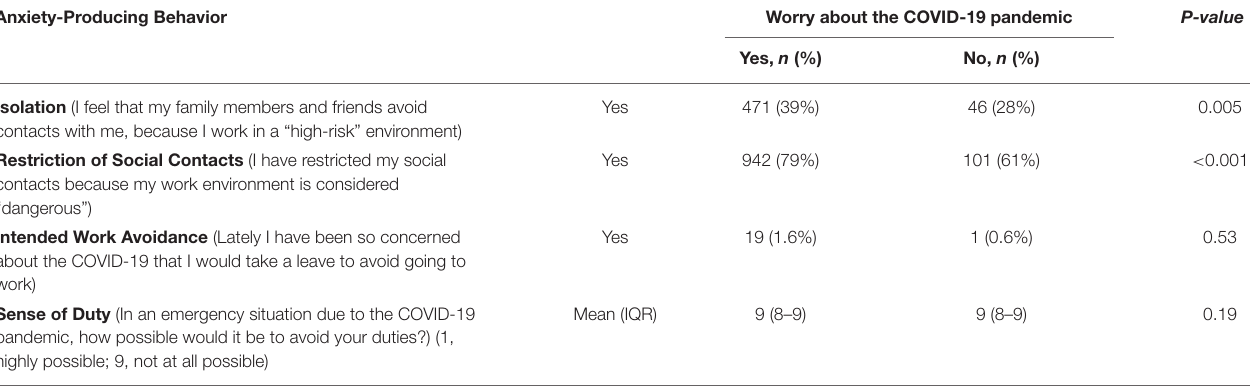
TABLE 7 | Association between “Worry about the COVID-19 pandemic” and anxiety-producing behaviors among 1,364 Chinese nurses during the COVID-19 pandemic. Anxiety-Producing Behavior Worry about the COVID-19 pandemic P-value Yes, n (%) No, n